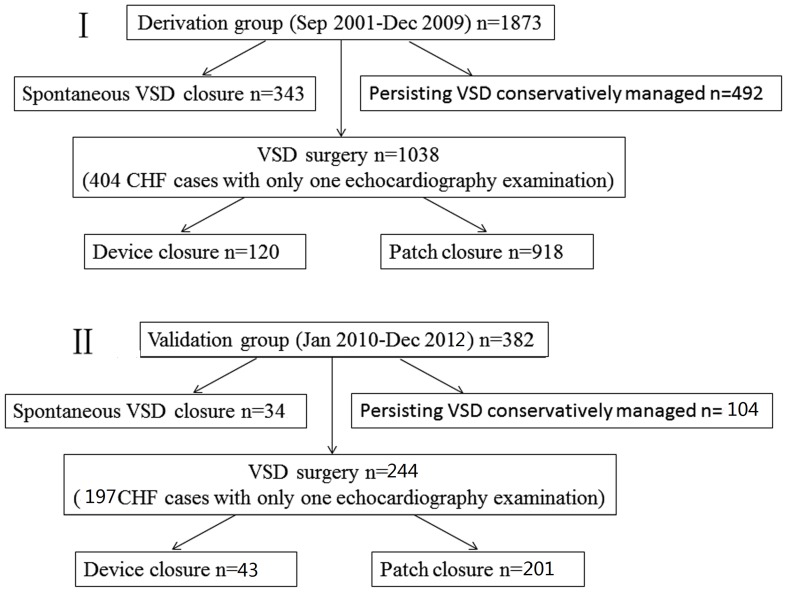
Flow chart of the two patient groups for establishment of a spontaneous PMVSD closure prediction scoring system.(VSD, ventricular septal defect; CHF, congestive heart failure).